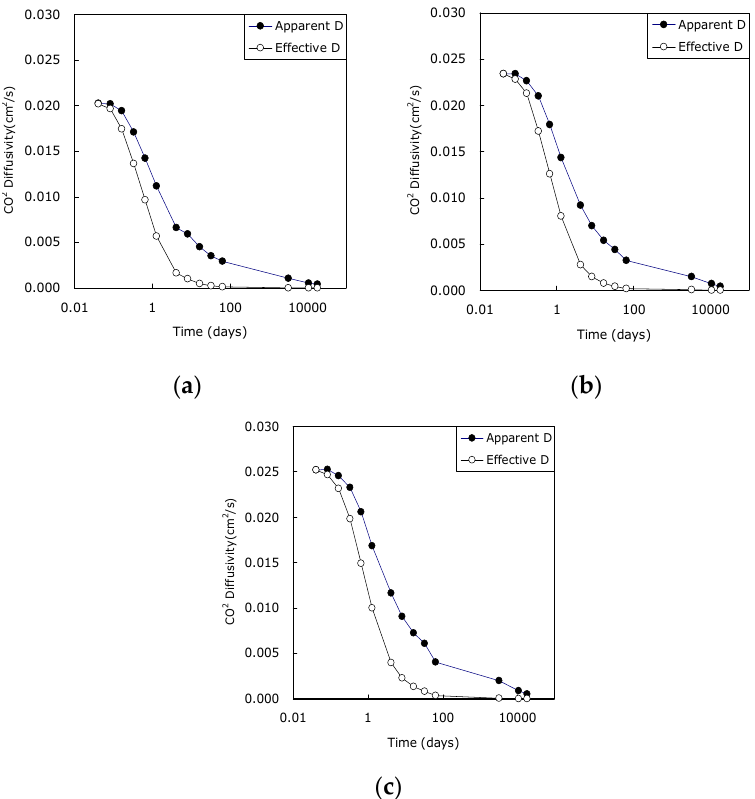
Figure 5. Apparent and e ff ective CO 2 di ff usivity of noncarbonated concrete. ( a ) w / c 0.45; ( b ) w / c 0.50; ( c ) w / c 0.55.